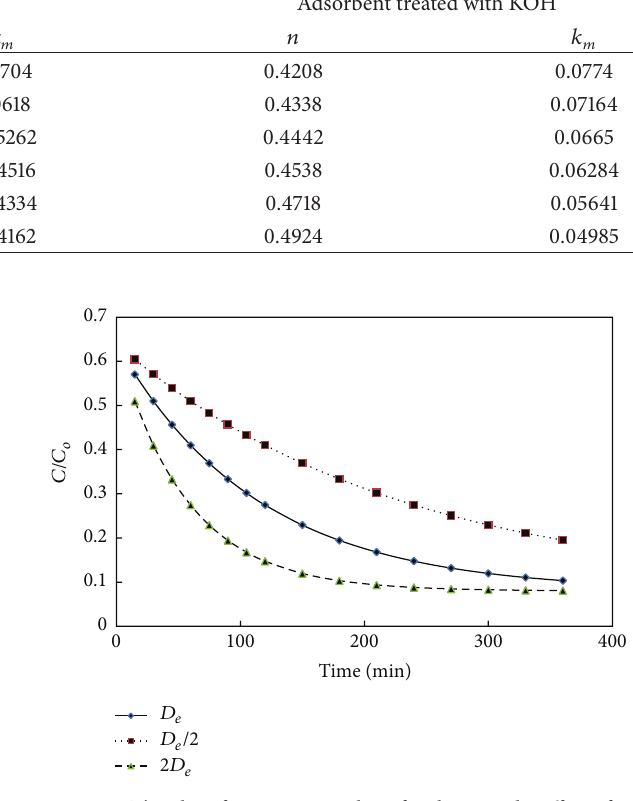
on the adsorption process for the adsorbent treated with HCl.